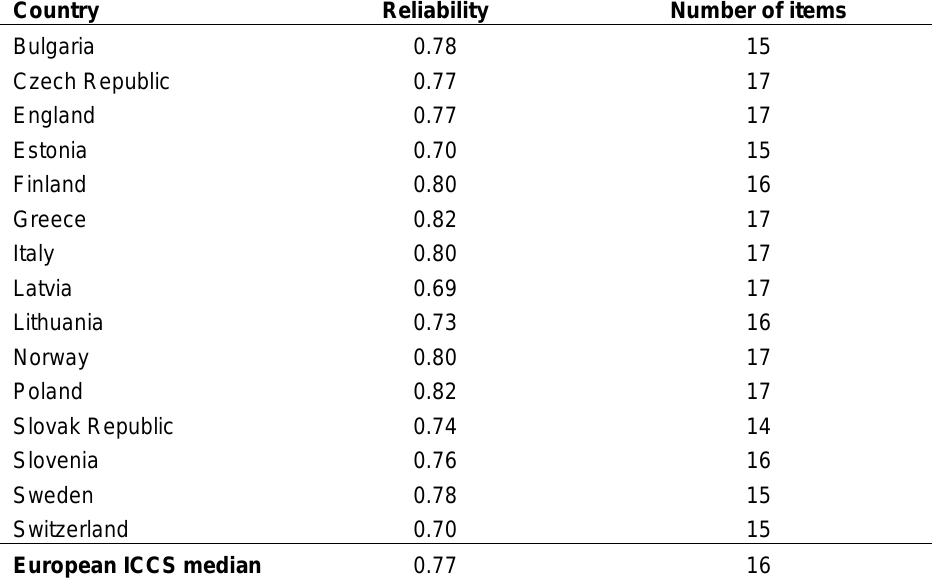
Test reliabilities for link items (Cronbach's